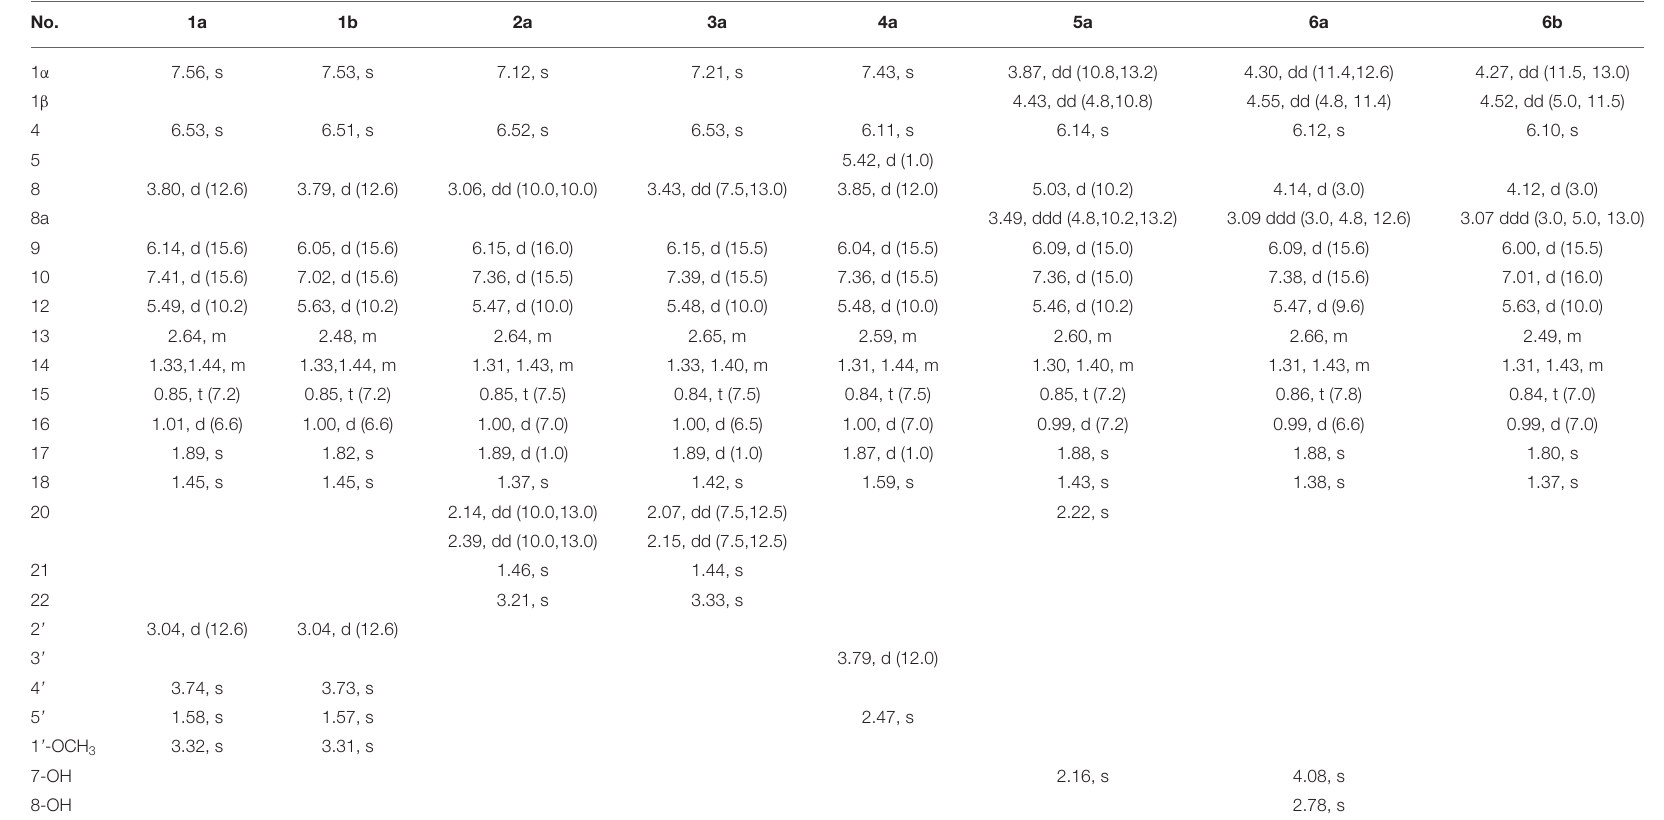
TABLE 1 | 1 H nuclear magnetic resonance (NMR) data of compounds 1–6 (chloroform- d , δ in ppm, J in Hz).